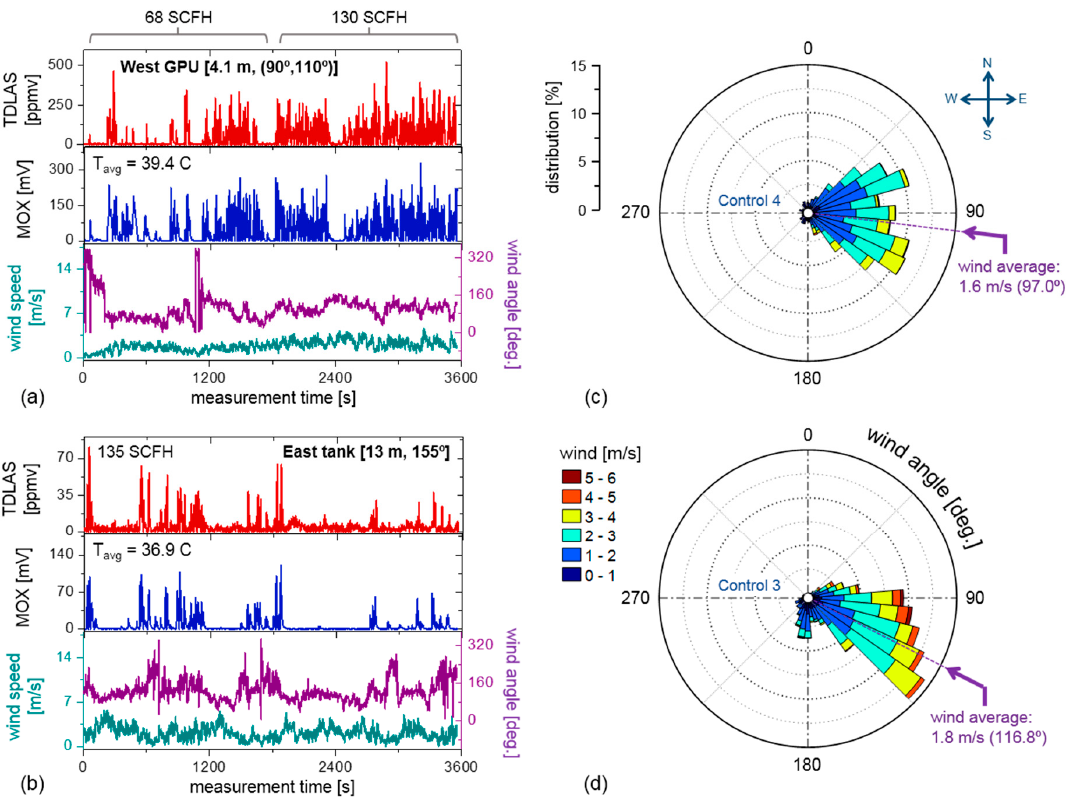
Figure 6. ( a ) Concurrent measurements of CH 4 from the TDLAS, MOX, and anemometer data for Control 4. General visual agreement is observed between the TDLAS and MOX sensors. The average temperature of 39.4 ◦ C was acquired using an internal thermistor in the MOX sensor unit. ( b ) Similar results for Control 3. ( c , d ) depict the corresponding wind-rose of the anemometer data. The results of AOA retrieval for these experiments are shown later in Figure 8, Section 3.3.